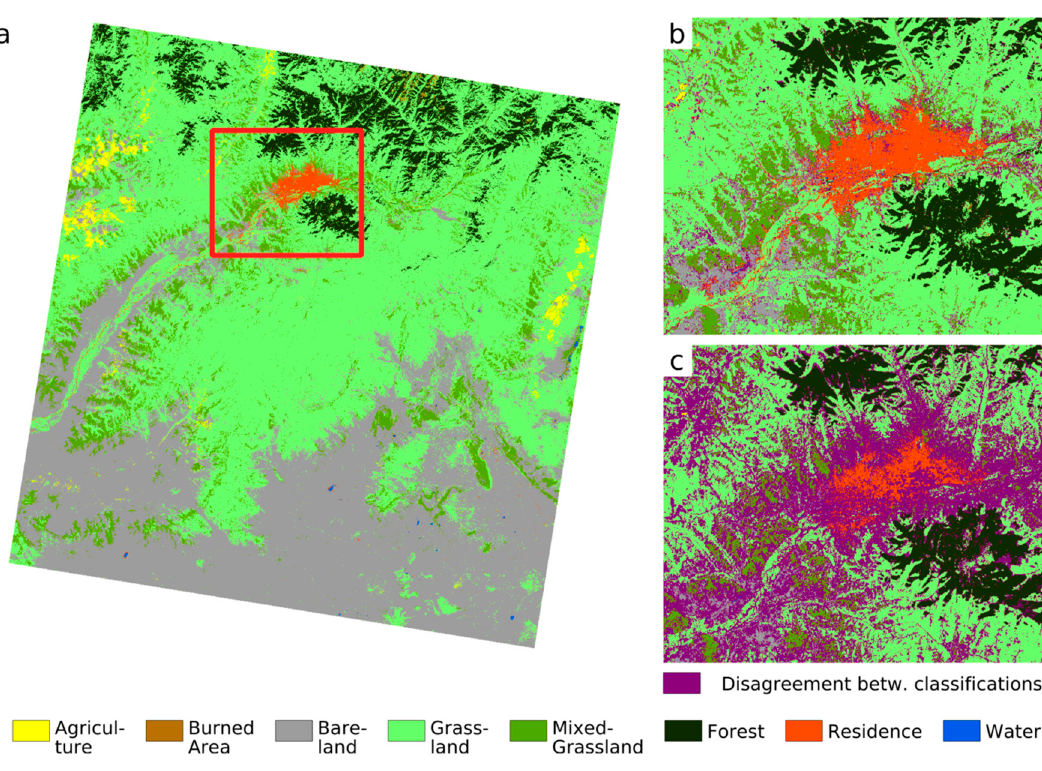
Figure 6. ( a ) Mode of classifications giving the class with the highest frequency per pixel among all 8 classifications. ( b ) Agreement between mode of classifications and the classification with the highest OA (classification based on Dataset 7) for the area around Ulaanbaatar indicated by the red box in (a). Pink areas mark disagreement. ( c ) Same as ( b ) but showing disagreement between all single classifications. In this respect, all pixels are colored in pink that are classified into at least two different classes considering all classifications. ( d ) Frequency of class numbers observed among all classifications given as class wise percentage of pixels in mode classification. The bars marked with zero show the percentage of pixels with agreement in all classifications. For instance, 76% of forest pixels (dark green bar) in mode classification are classified as forest in all other classifications; 22% of forest pixels in mode classification are put into another class than forest in at least one other classification; 2% of forested pixels in mode classification are put into 2 other classes. Please note that numbers in ( d ) are calculated for the entire area of the classifications.